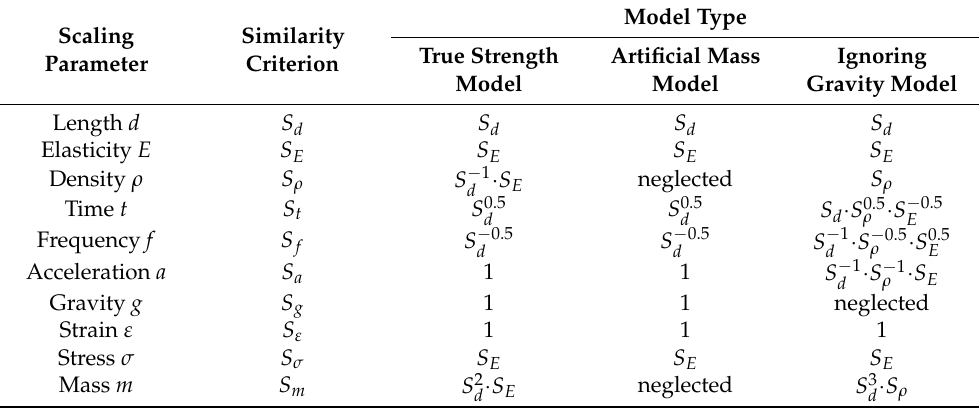
Table 1. Similarity criteria for different types of dynamic